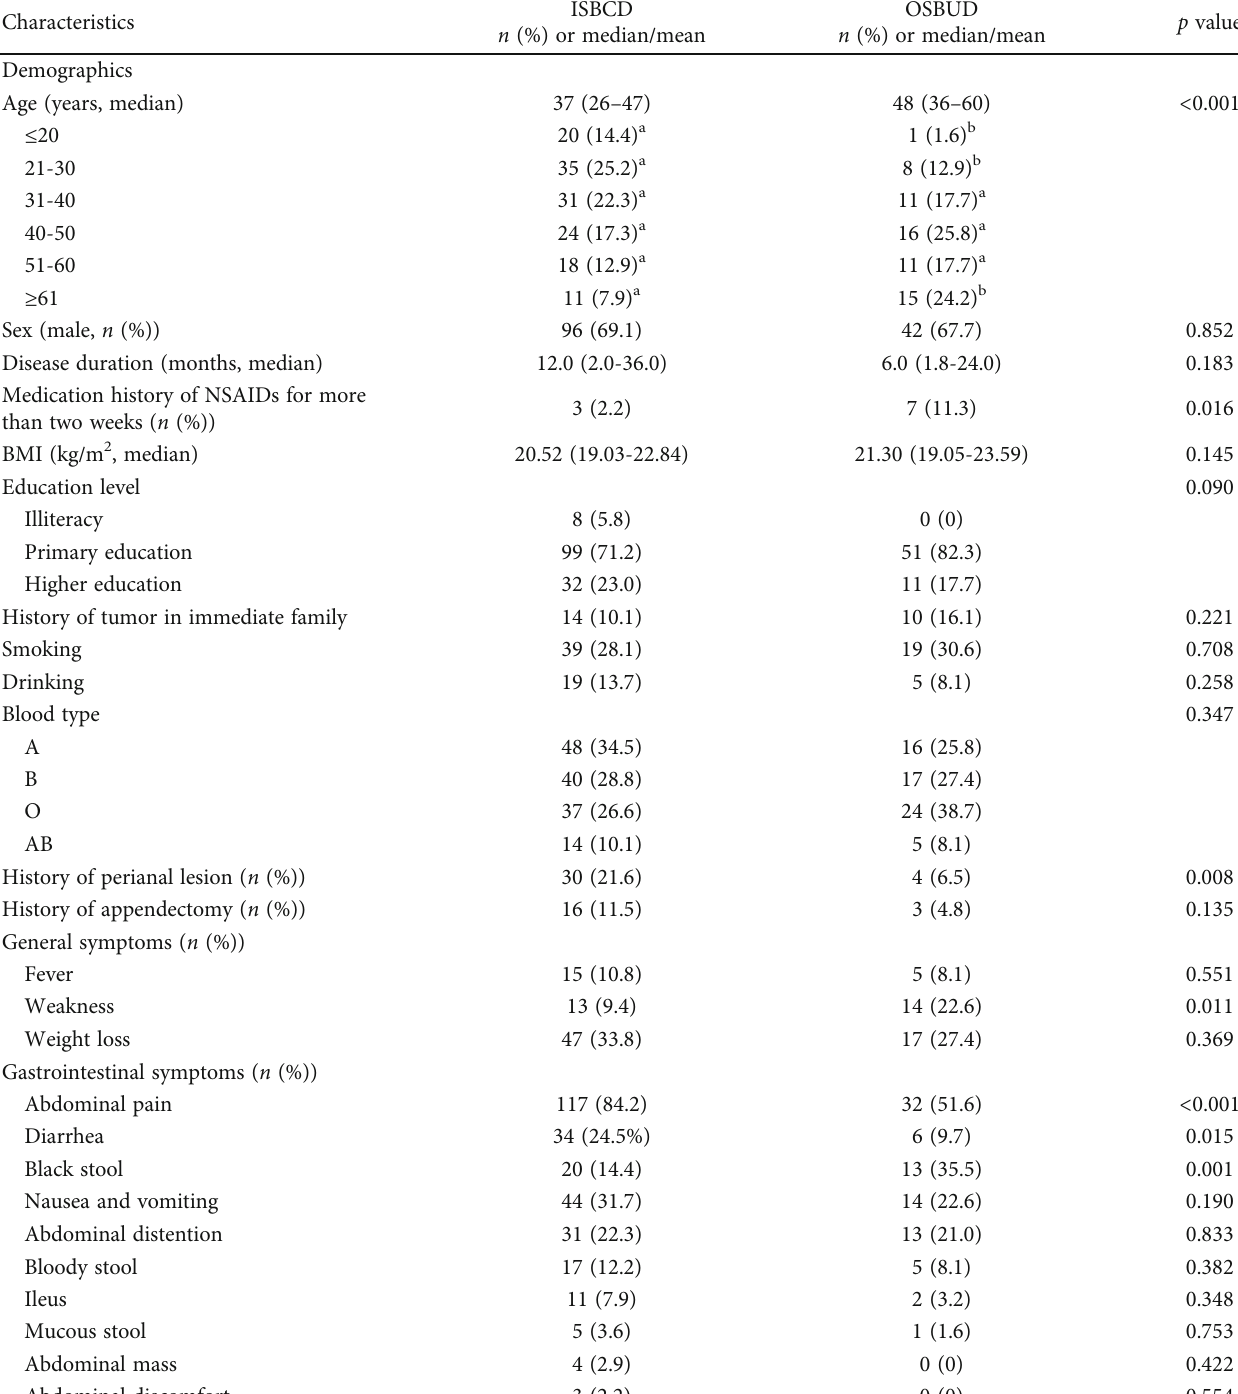
Table 2: Demographic and clinical features of ISBCD and OSBUD